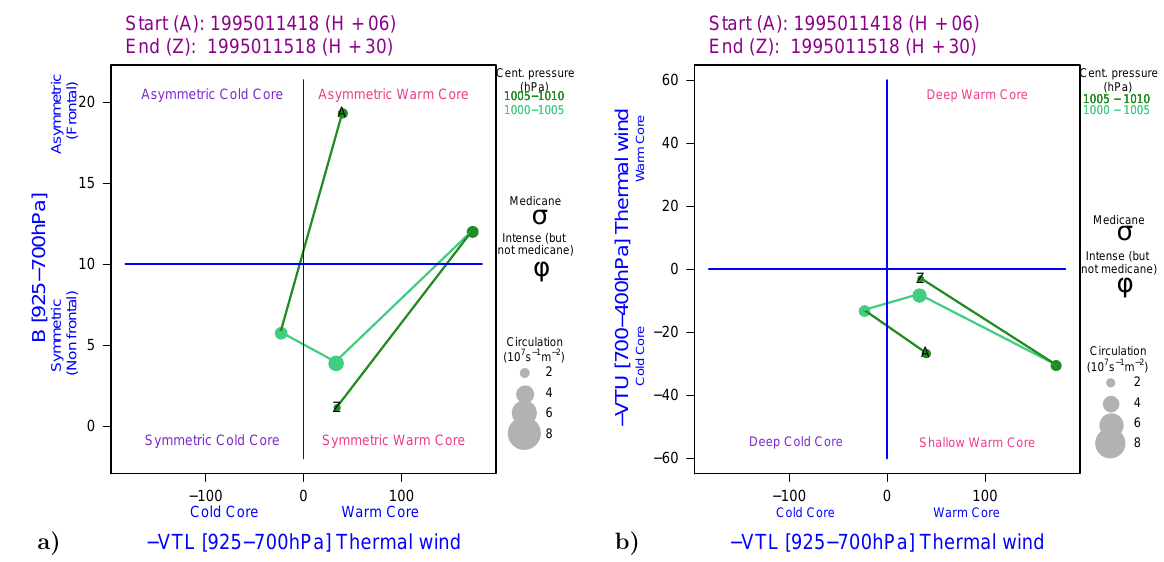
Fig. 8. Cyclone phase diagrams I (a) and II (b) , as Fig. 3, for January 1995 orographic cyclone